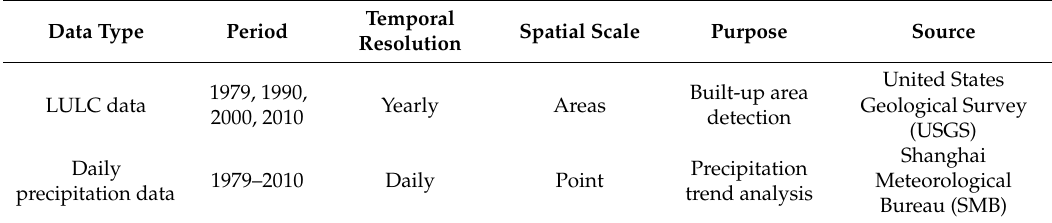
Table 1. Datasets used in this study.